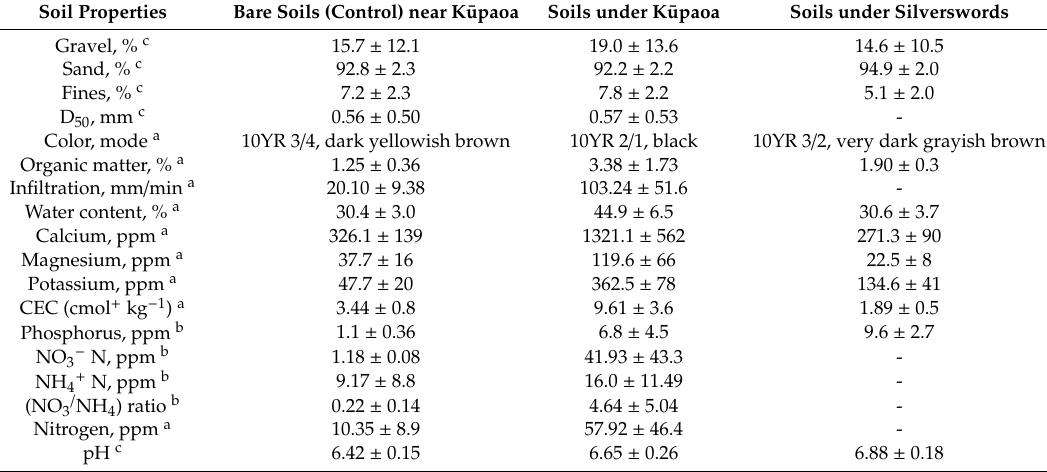
refer to K–S test comparisons for soils under k¯upaoa with control soils. Key : a : p < 0.001, b : p < 0.005, c : No significant di ff